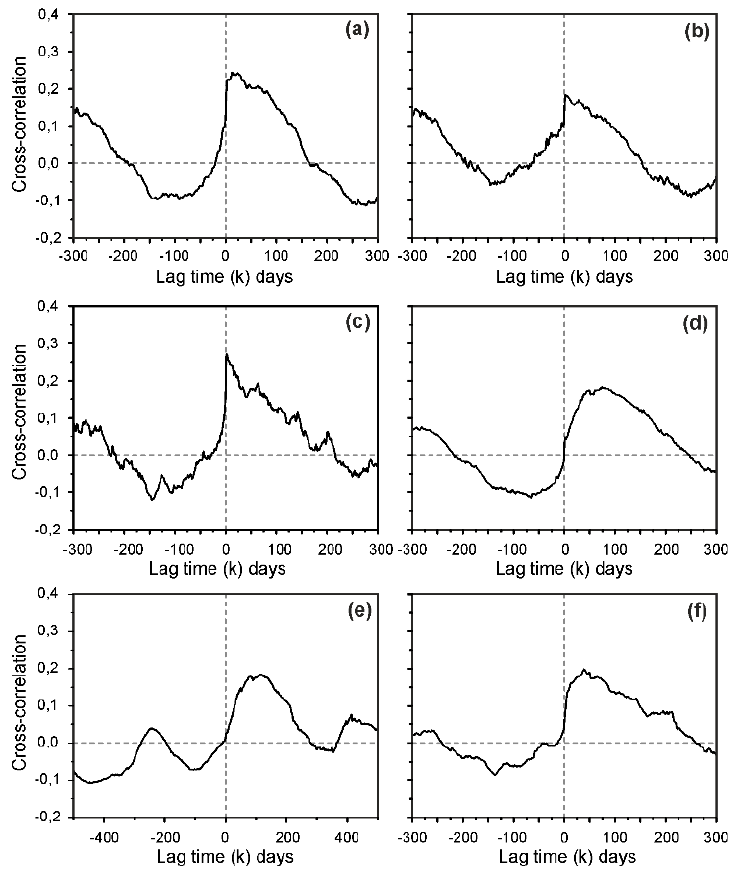
Figure 7. Cross-correlation functions of the analyzed aquifer springs; ( a ) Scirca spring, ( b ) Vaccara spring, ( c ) Boschetto spring, ( d ) Capo d’Acqua spring, ( e ) San Giovenale spring, and ( f ) Bagnara spring.